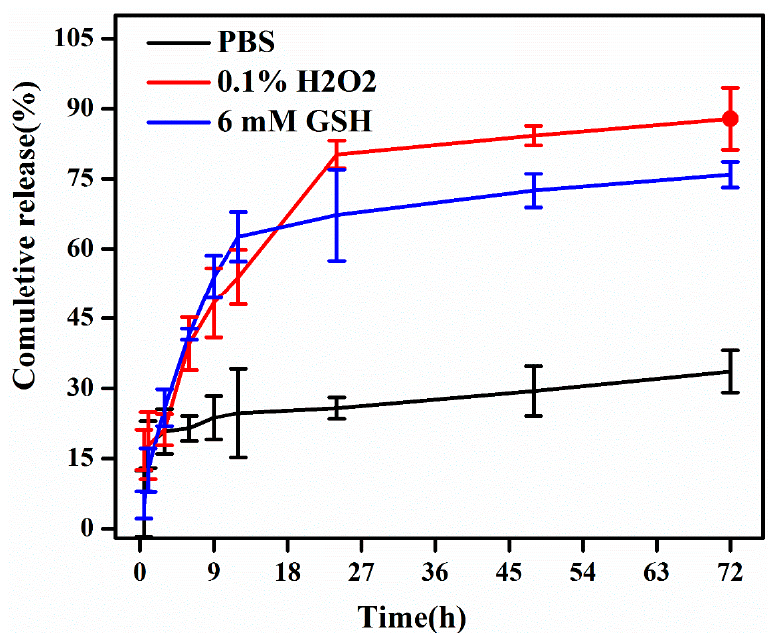
Figure 5. Redox-responsive drug release profile of Hep–Chl self-assembled prodrug nanoparticles in PBS only, 2 mg/mL GSH/PBS, and 0.1% H 2 O 2 PBS.